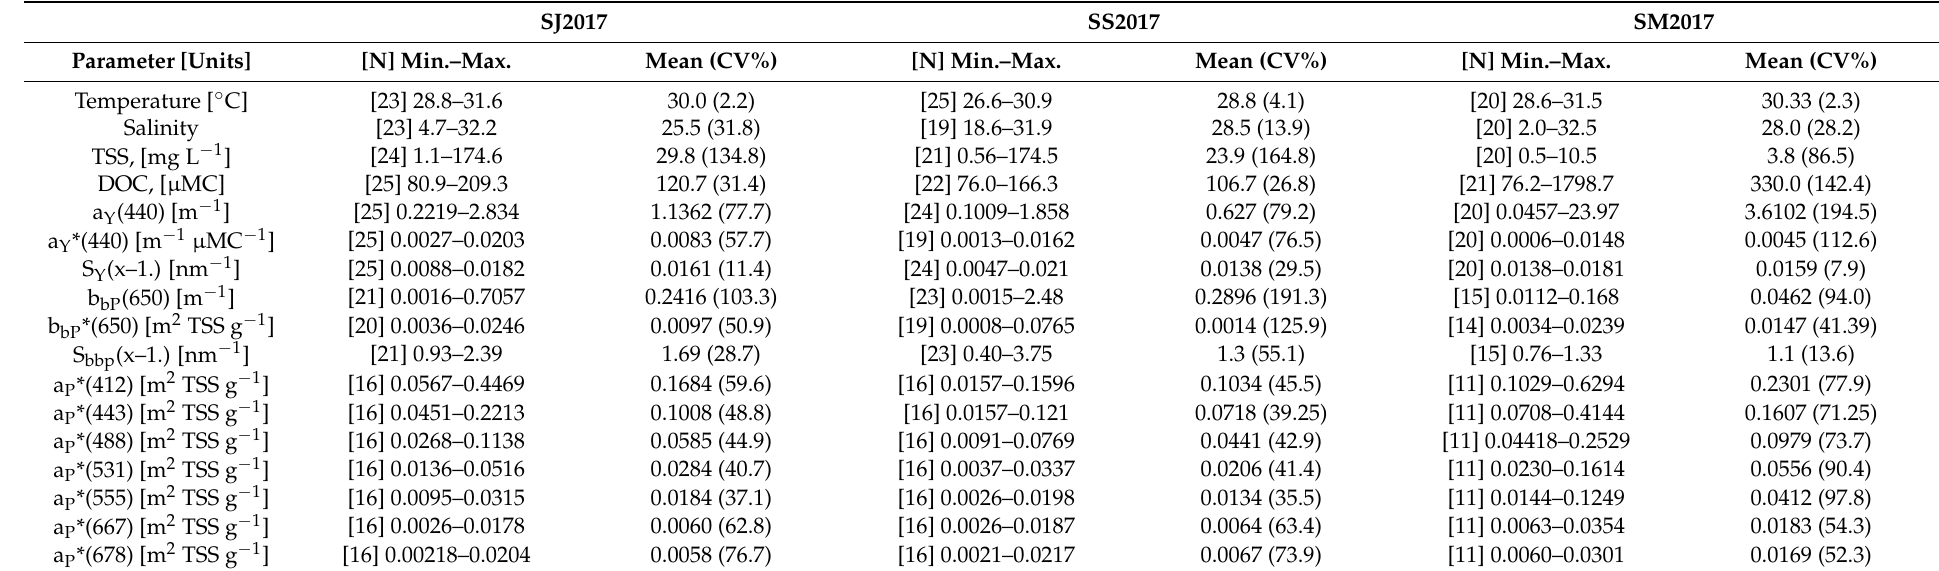
Table 1. Observed bio-optical variability in Sarawak coastal waters during 2017 field